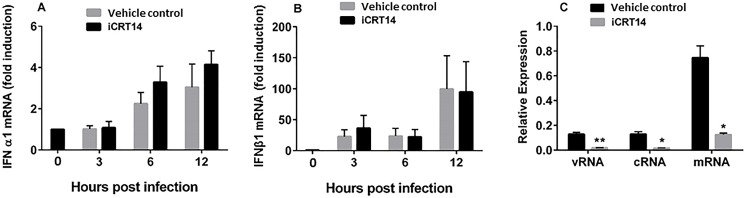
Effects of iCRT14 on influenza virus-induced IFN response and iCRT14-mediated inhibition of influenza virus RNA synthesis in Vero cells.(A, B) A549 cells were infected with A/PR/8/34 at an MOI of 1 for various times. The cells were treated with iCRT14 (12.5 μM) or vehicle control 1 h prior to infection. IFN α1 and β1 mRNA levels were determined by real-time PCR and normalized to GAPDH. The data are expressed as fold change relative to mock infection. (C) Vero cells were infected with A/PR/8/34 at an MOI of 5. The cells were treated with iCRT14 (12.5 μM) or vehicle control 1 h prior to infection. The cRNA, vRNA and mRNA levels of the NP gene were determined at 5 h post-infection using real-time PCR and normalized to GAPDH. The data are expressed as relative expression. The results of 3 independent experiments are presented as the mean ± SE. *p<0.05 vs. vehicle control, *p<0.01 vs. vehicle control (Student’s t-test).